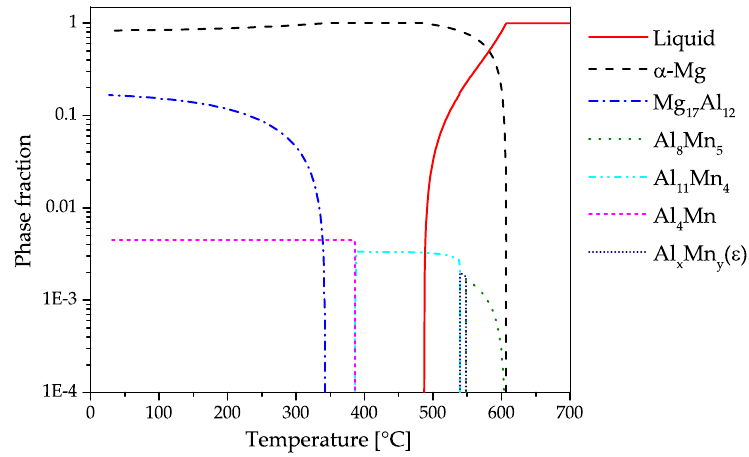
Figure 13. CALPHAD calculations (for further information see Appendix A) of AZ80 in a temperature range of 25 to 700 ◦ C, showing phase fractions of 10 − 4 to 1.